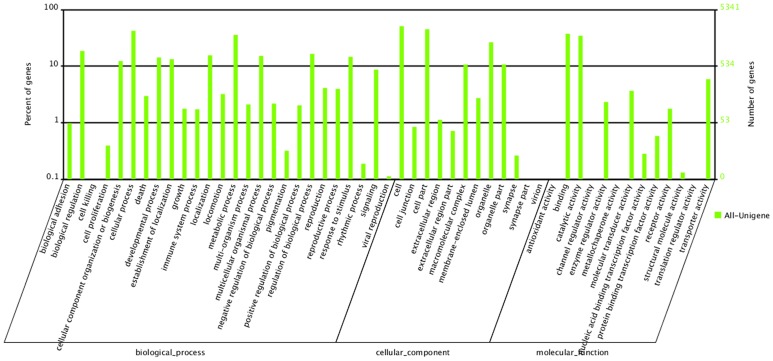
Gene Ontology (GO) categories of the unigenes.Unigenes were annotated in three categories: biological processes (26 sub-categories, 12,428 sequences), cellular components (12 sub-categories, 7,977 sequences), and molecular functions (13 sub-categories, 4,625 sequences).